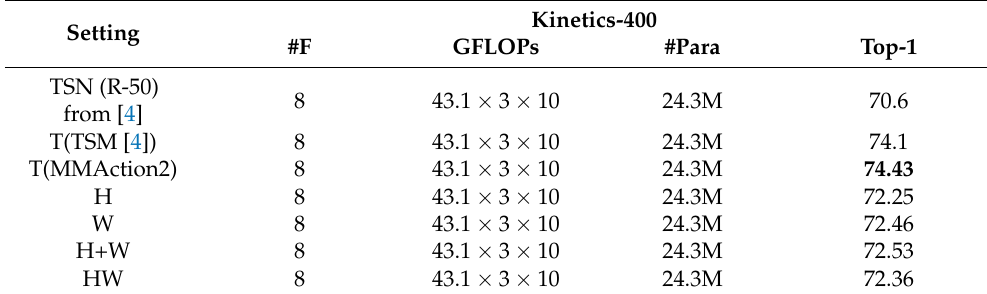
Table 2. Network performance under different shift operations in spatial dimensions. The α = 1/4, which is consistent with TSM.